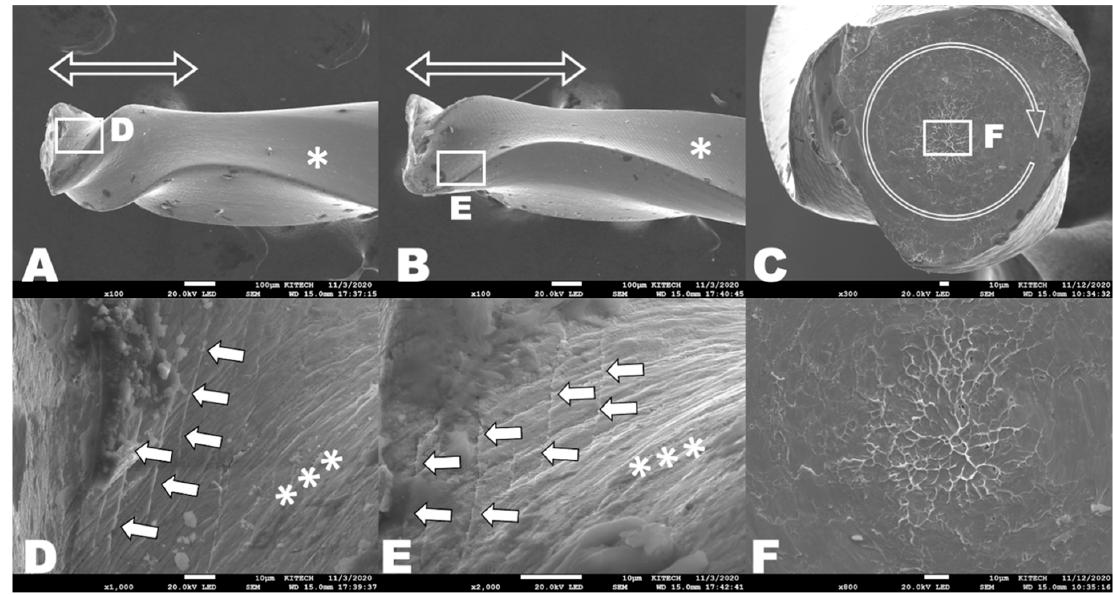
Figure 3. Scanning electron micrographs of the fracture fragments after torsional resistance tests. Longitudinal aspects of the fracture fragments from samples of group-N ( A ) and group-U ( B ). Cross-sectional aspect from one sample of group-S ( C , F ). ( A , B ) Vacant double-sided arrows indicate the unwound helix of the flute. Specimen of B shows longer unwound helix than the specimen of A. ( C ) Circular arrow shows circular abrasion mark and multiple fibrous dimples ( C , F ) at the center of rotation. Linear and straight machining grooves were found at ( A , B ) uncompressed area (*) but ( D , E ) compressed area shows irregular wrinkles (***) and slippages by microcracks (ar- rows). No specific differences according to the